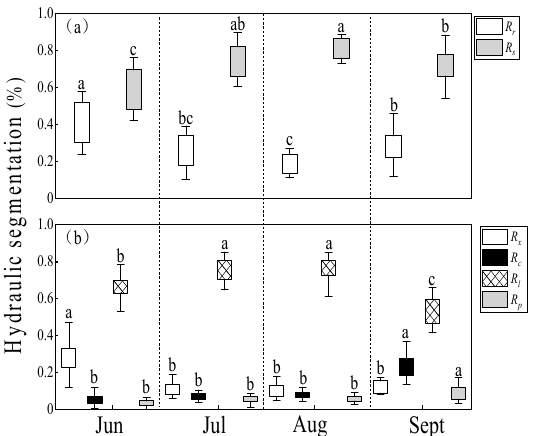
Figure 3. Seasonal changes in hydraulic segmentation for ( a ) whole-root / shoot and ( b ) parts of the leafy branch. (a): R r (open boxes) indicates hydraulic resistance ratio for whole-roots, R s (light-shaded boxes) for whole shoots. (b): R x (open boxes) indicates hydraulic resistance ratio for one-year shoots, R c (dark-shaded boxes) for current-year shoots, R l (cross-hatched boxes) for leaf blades, and R p (light-shaded boxes) for petioles. Lower-case letters over the bars denote significance levels based on ANOVA post hoc means using LSD analysis ( p < 0.05).